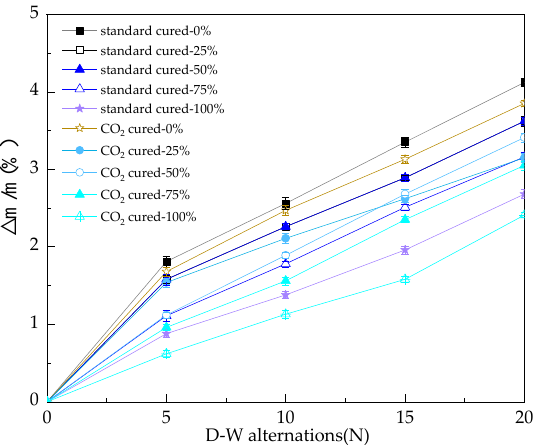
Figure 4. The mass loss rate of steel bars during D – W alternations.